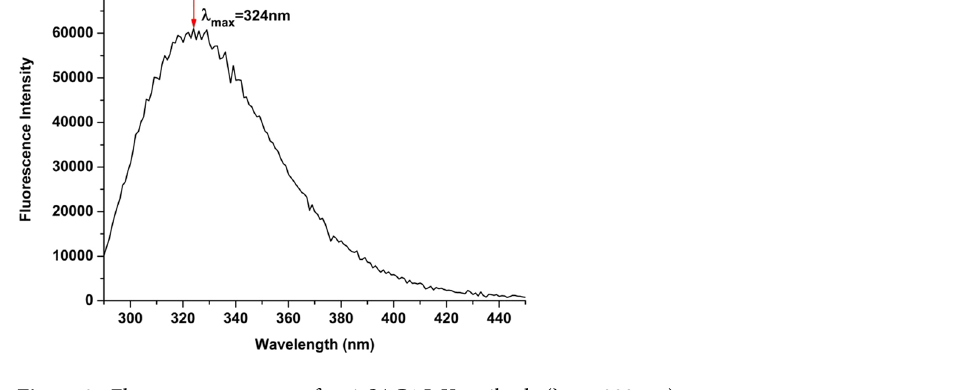
Figure 2. Fluorescence spectra of anti-SAG1 IgY antibody ( λ ex = 280